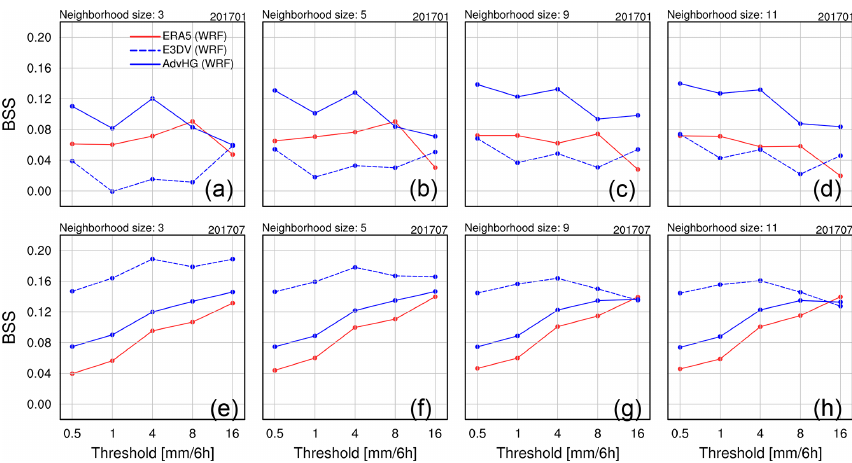
Figure 10. Brier skill score of the probabilistic postprocessed forecast with reference to the WRF-based ERA-I for (a–d) January and (e–h) July 2017 (solid blue line: AdvHG; dashed blue line: E3DVAR; solid red line: WRF-based